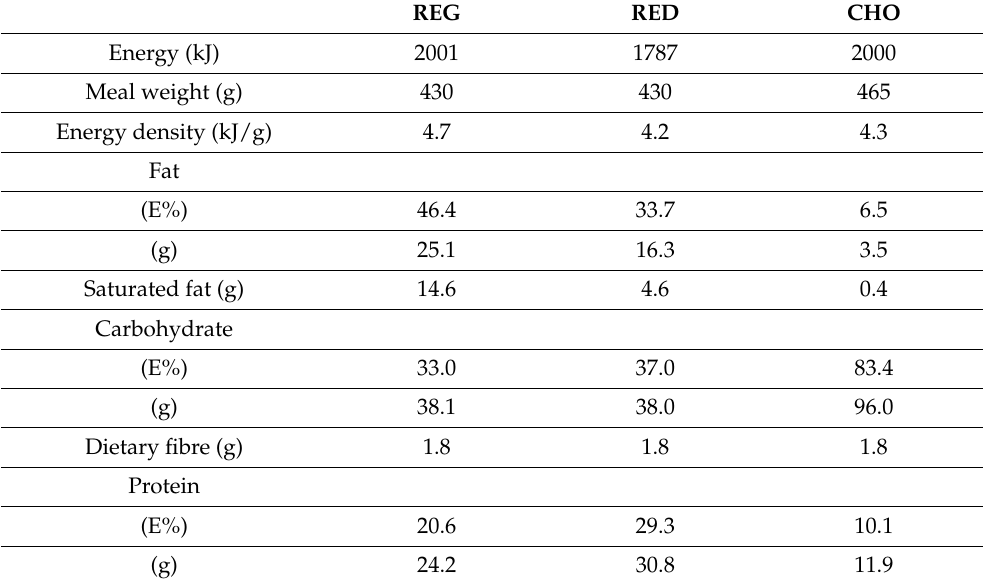
Table 1. Composition of the three breakfast meals 1